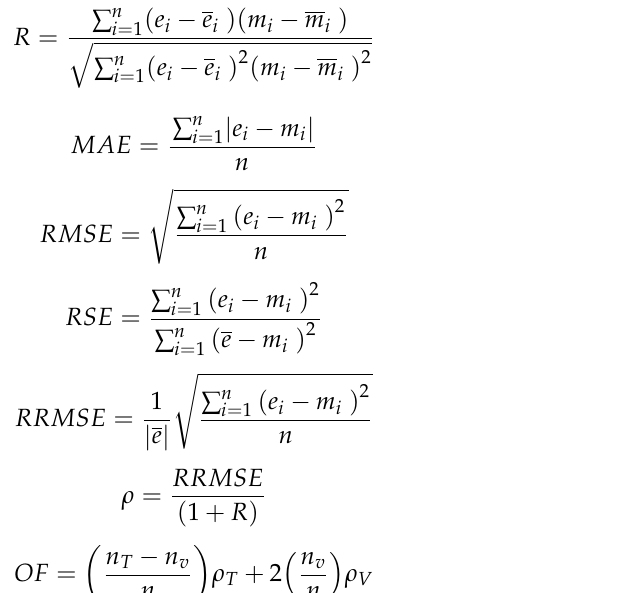
where e i and m i are the nth experimental and model CS (%), respectively; e i and m i denote the average values of the experimental and model CS (%), respectively; and n is the number of samples in the dataset. The subscripts T and V in Equation (7) represent the training and validation data, respectively, and n is the total number of sample